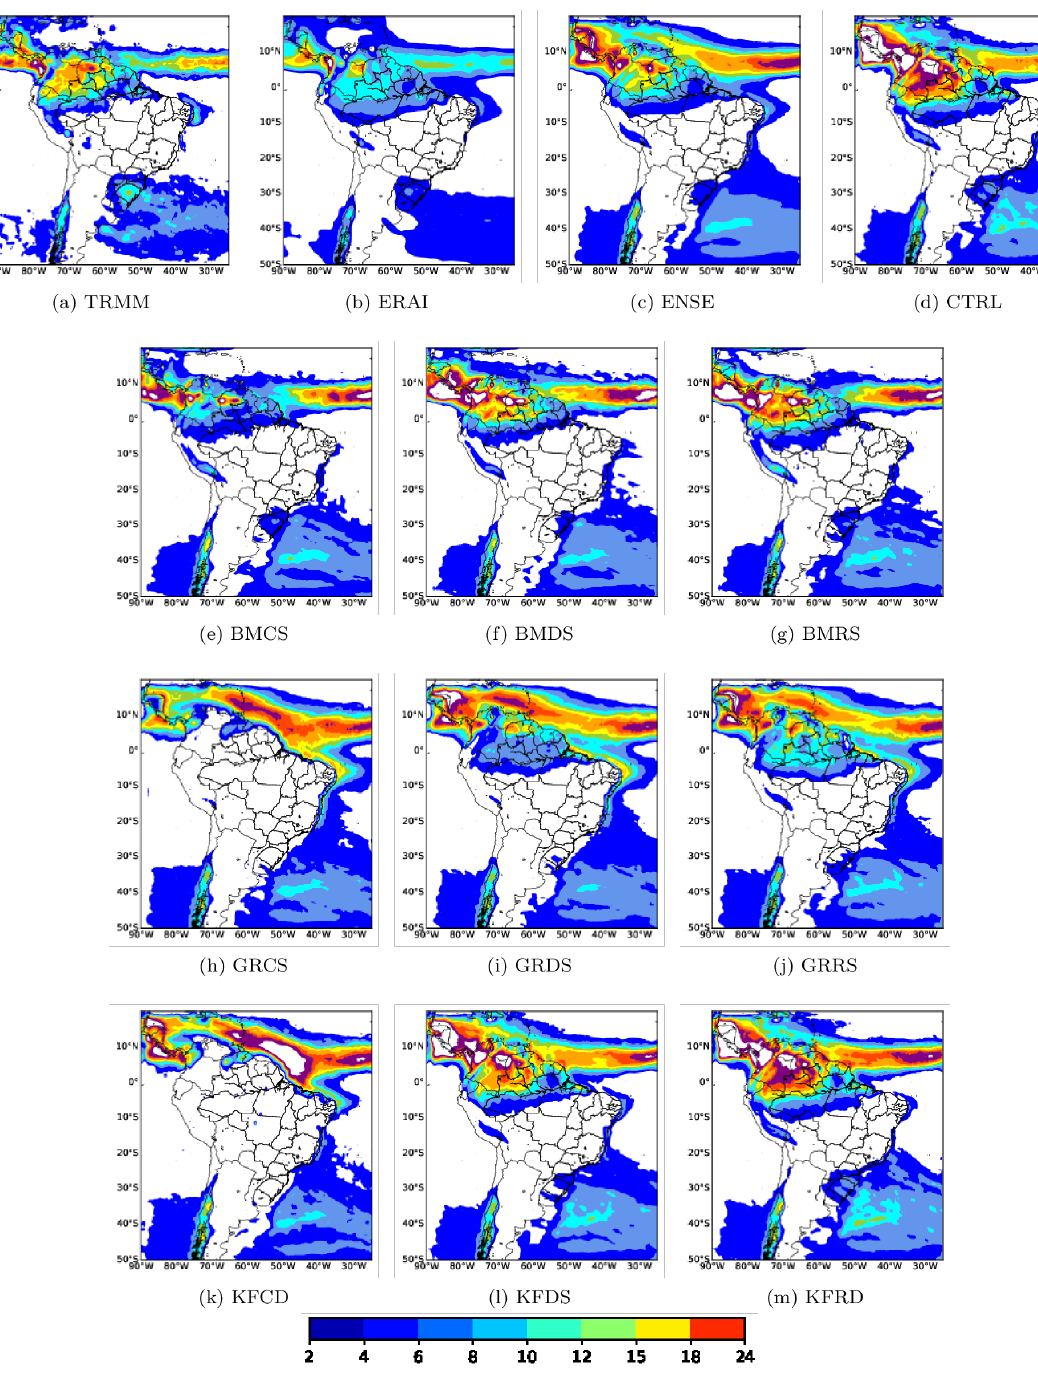
Figure 5. As in Figure 3, but for June-July-August